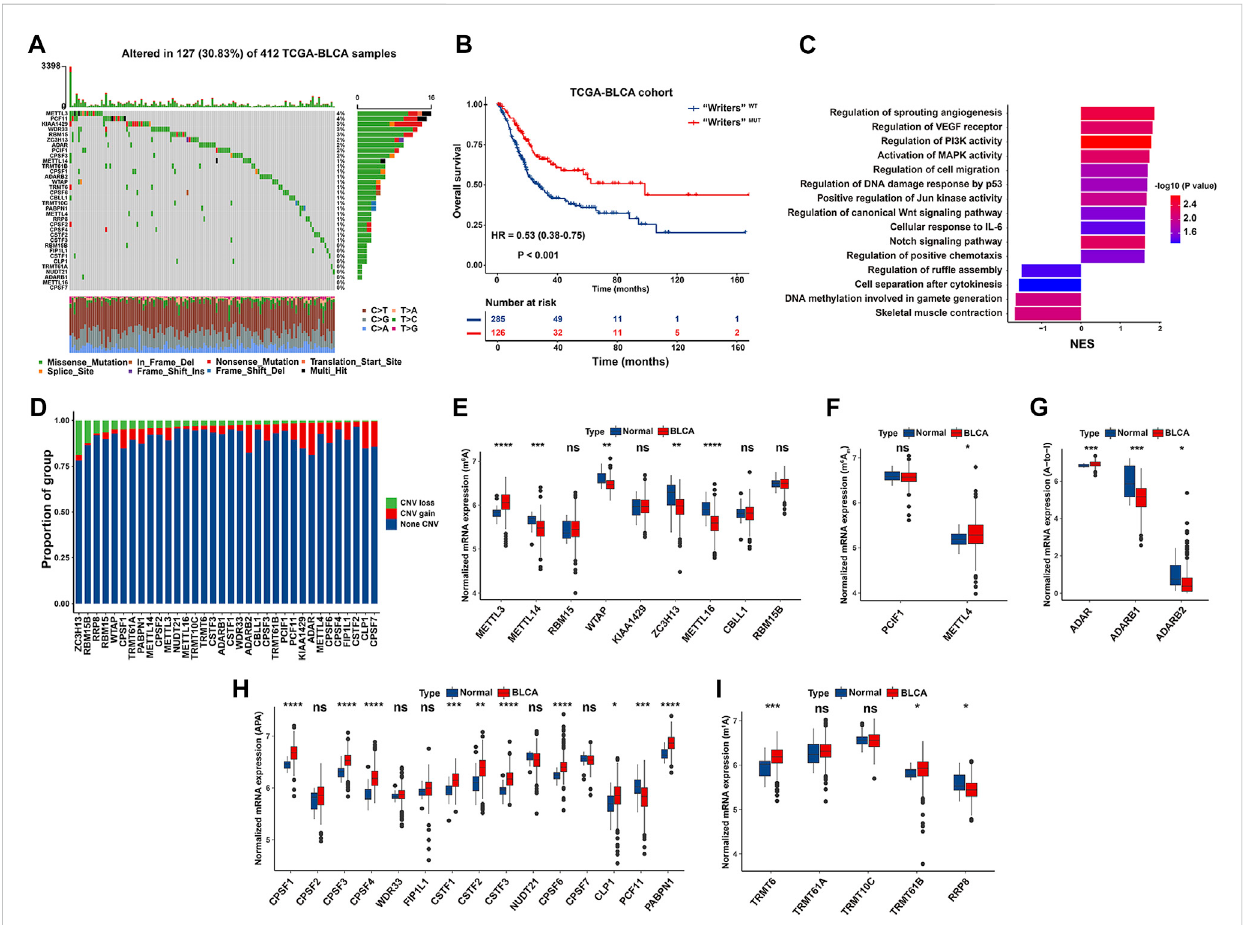
FIGURE 2 GeneticandtranscriptionalcharacteristicsofRNAmodi fi cation “ writers ” intheTCGA-BLCAcohort. (A) Waterfallplotshowingmutationfrequencyof 34 “ writers ” in 412 BCa cases. The upper and the right bar chart represented the TMB for individual sample, and the proportion of mutation type of each “ writer ” , respectively. (B) Kaplan-Meier curve of OS in “ Writers ” MUT and “ Writers ” WT BCa patients. (C) Bar chart depicting signi fi cantly biological pathways enriched in “ Writers ” WT (Right) or “ Writers ” MUT (Left) BCa patients by GSEA. (D) Bar chart depicting CNV frequency of 34 RNA modi fi cation “ writers ” . (E – I) Boxplot representing mRNA levels of 34 “ writers ” between normal tissues and BCa samples, with p values derived from Wilcoxon rank sum